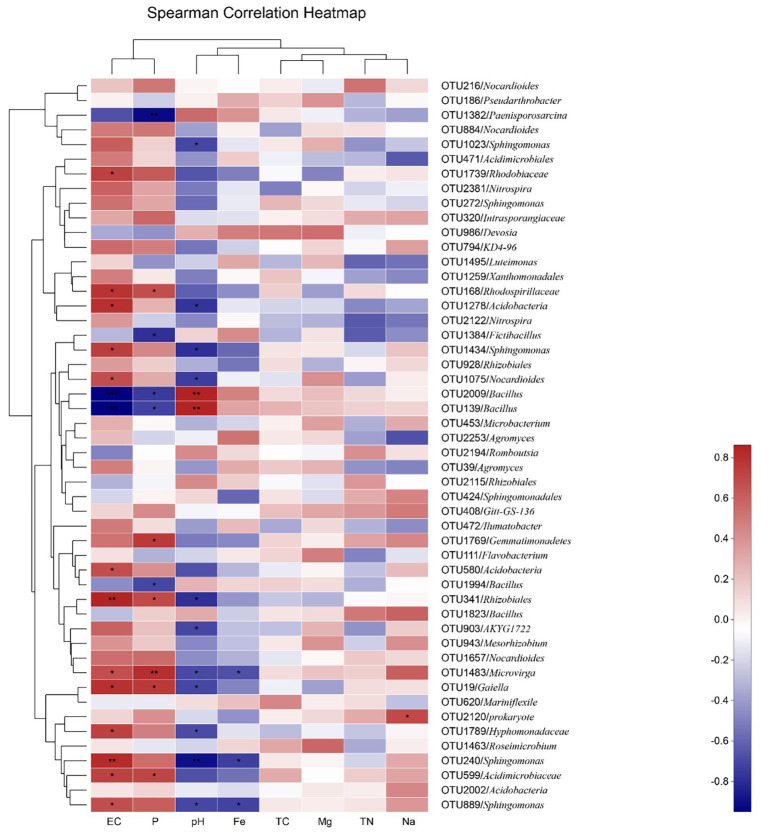
The heatmap depicts the relative abundances of the top 50 operational taxonomic units (OTUs) and Spearman’s correlations between OTU abundances and soil properties. The top 50 OTUs based on the values of mean decrease in the Gini index are selected and only the ones with average relative abundances of >0.1% are shown. EC, Electrical Conductivity; P, phosphorus; Fe, iron; TC, total carbon; Mg, magnesium; TN, total nitrogen; and Na, Sodium.